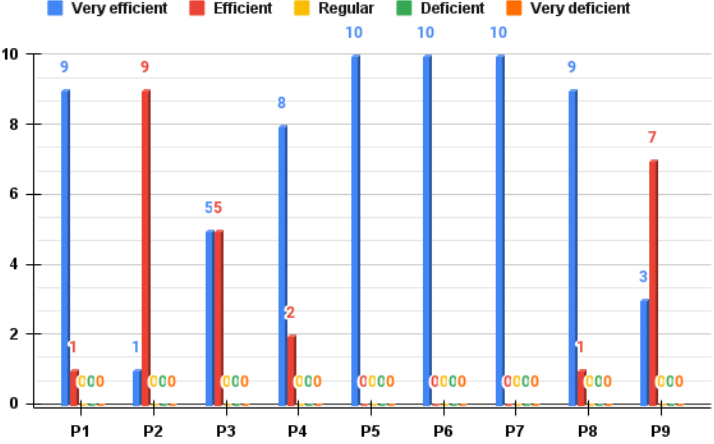
Figure 10. Results of the satisfaction survey for users of the upper torso rehabilitation support orthosis